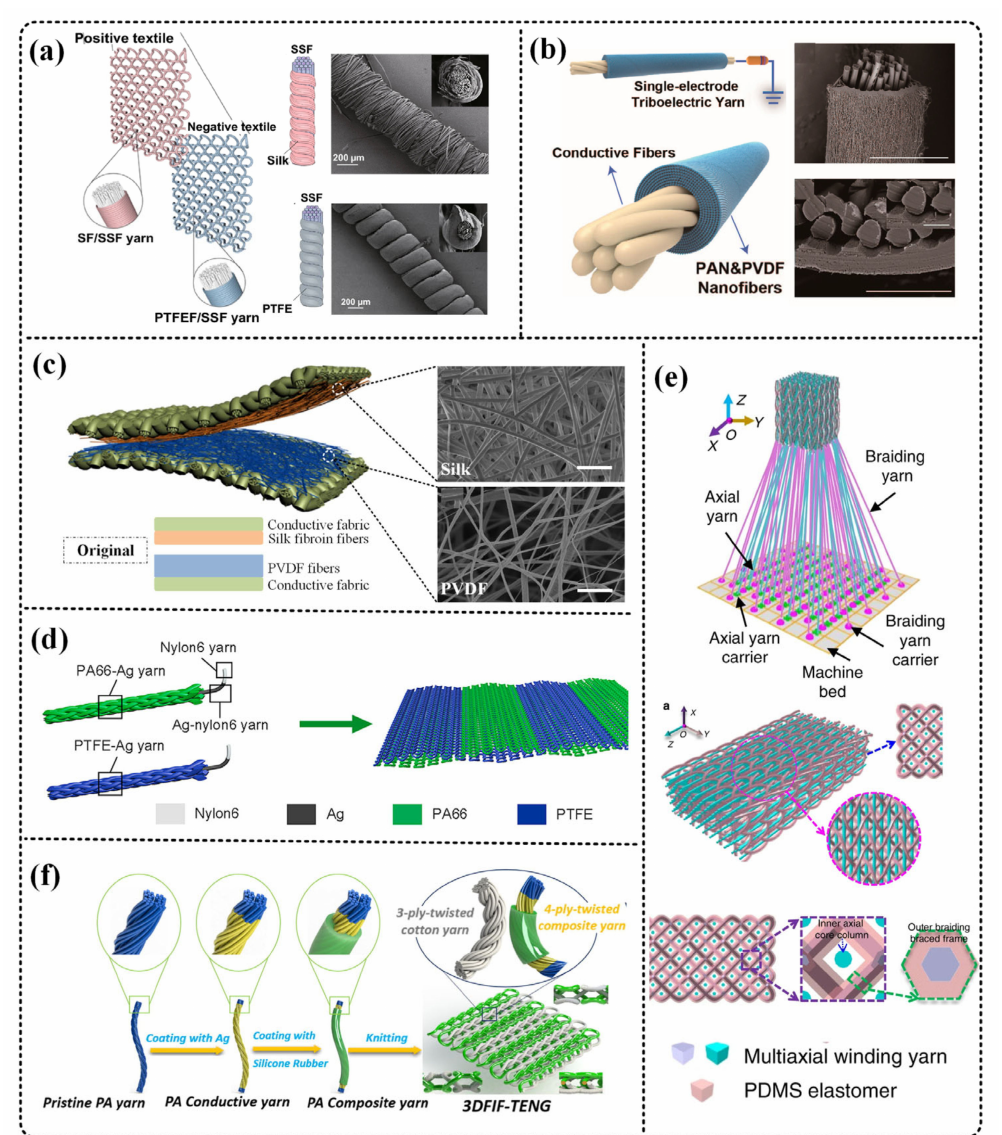
Figure 4. Different T-TENGs as energy harvesters. ( a – c ) Fiber-based TENGs. ( d – f ) Fabric-based TENGs. ( a ) Ye et al. manufactured silk fiber (SF), polytetrafluoroethylene fiber (PTFEF), and stainless steel fiber (SSF) into TENG yarn with a core-shell structure. Reproduced with permission from Springer Nature (2017) [36]. ( b ) Ma et al. produced a single- electrode triboelectric yarn with a spiral core-shell structure. The inner layer uses conductive silver nanowires, and the outer layer uses polyvinylidene fluoride (PVDF) and polyacrylonitrile (PAN) hybrid nanofibers. Reproduced with permission from American Chemical Society (2020) [37]. ( c ) Guo et al. electrostatically spun silk fibroin and polyvinylidene fluoride nanofibers onto conductive fabrics to manufacture a full-fiber hybrid piezoelectric-reinforced triboelectric nanogenerator. Reproduced with permission from Elsevier (2018) [90]. ( d ) Dong et al. used silver yarn wrapped with nylon and PTFE threads for knitting, and obtained fabric-based TENG. Reproduced with permission from Elsevier (2020) [92]. ( e ) Dong et al. designed a stable and soft 3D TENG fabric with the aid of a three-dimensional five-way weave structure. Reproduced with permission from Springer Nature (2017) [93]. ( f ) Chen et al. used double-needle flat knitting technology to design a TENG with 3D double-sided interlock. Reproduced with permission from Elsevier (2020)